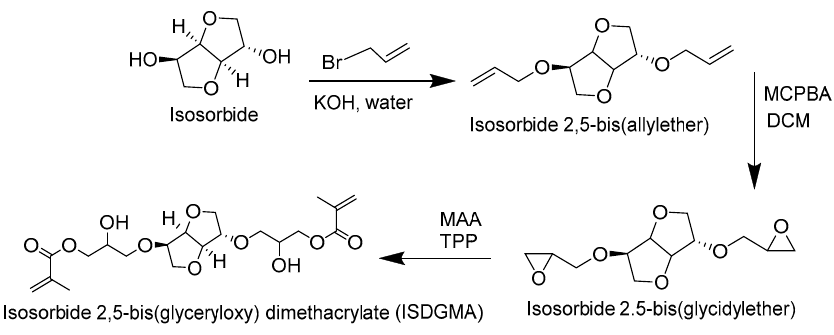
Figure 5. Reaction scheme for ISDGMA. Isosorbide was etherified in the presence of allyl bromide, potassium hydroxide, and water. The subsequent reaction step with MCPBA provided isosorbide diglycidyl ether. ISDGMA was synthesized via the addition of 75 mL (0.85 mol) methacrylic acid to 20 g (77 mmol) of isosorbide diglycidyl ether in the presence of 0.15 g (0.57 mmol) triphenylphosphine. MEHQ (12.5 mg, 0.1 mmol) and Phenothiazine (12.5 mg, 63 µmol) were added as inhibitors and stabilizers. The reaction was run at 76 °C for up to 24 h. Excess methacrylic acid was first removed under vacuum and then the crude was mixed with DCM and washed with a saturated sodium carbonate solution. The final product was purified through column chromatography (ethyl acetate/hexanes-95:5 w / w ) and stabilized with 500 ppm MeHQ. The synthesis and characterization of intermediate compounds are provided in the supplementary materials.